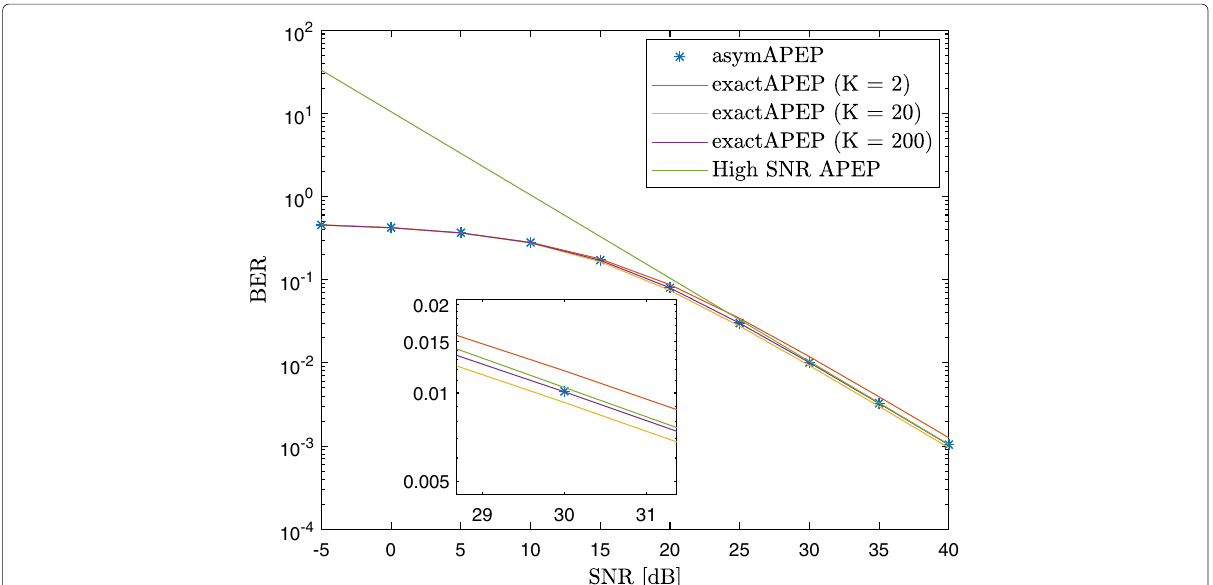
Fig. 8 ABEP of RecAnt-SM ( P = 2, N r = 1, M = 2 (BPSK)), as a function of K . The results are obtained by using RP 1 and RP